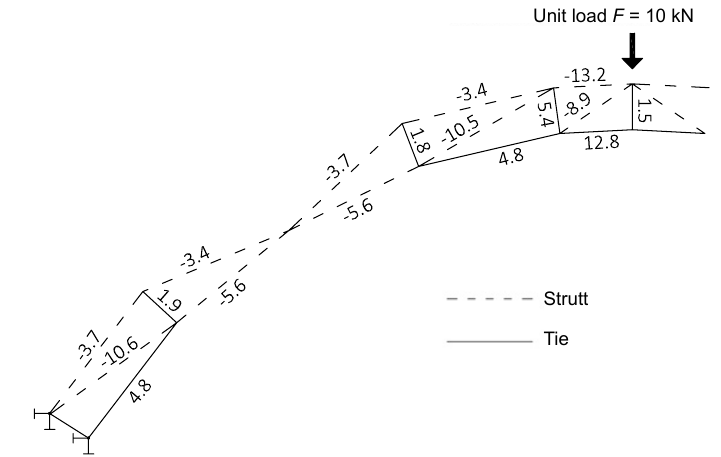
Figure 10. Internal forces determined in the modified Strut-and-Tie